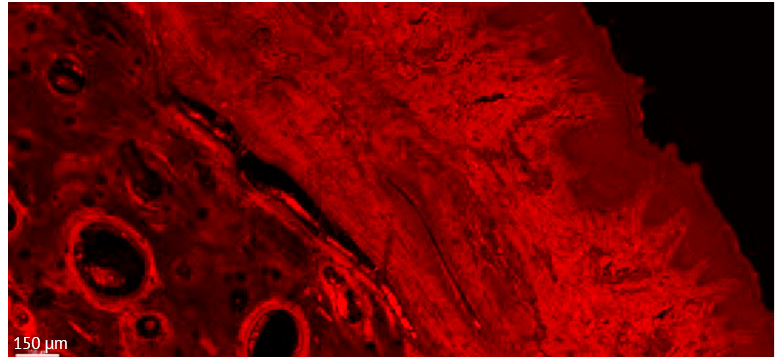
Figure 5. Detailed aspect of the soft tissue and bone in a thick section of a non-ligated implant. Note the presence of acanthosis of the covering epithelium. ICT is present in contact with bone and implant, promoting an active bone resorption. (implant #2, oral aspect; bar, 150 µm).